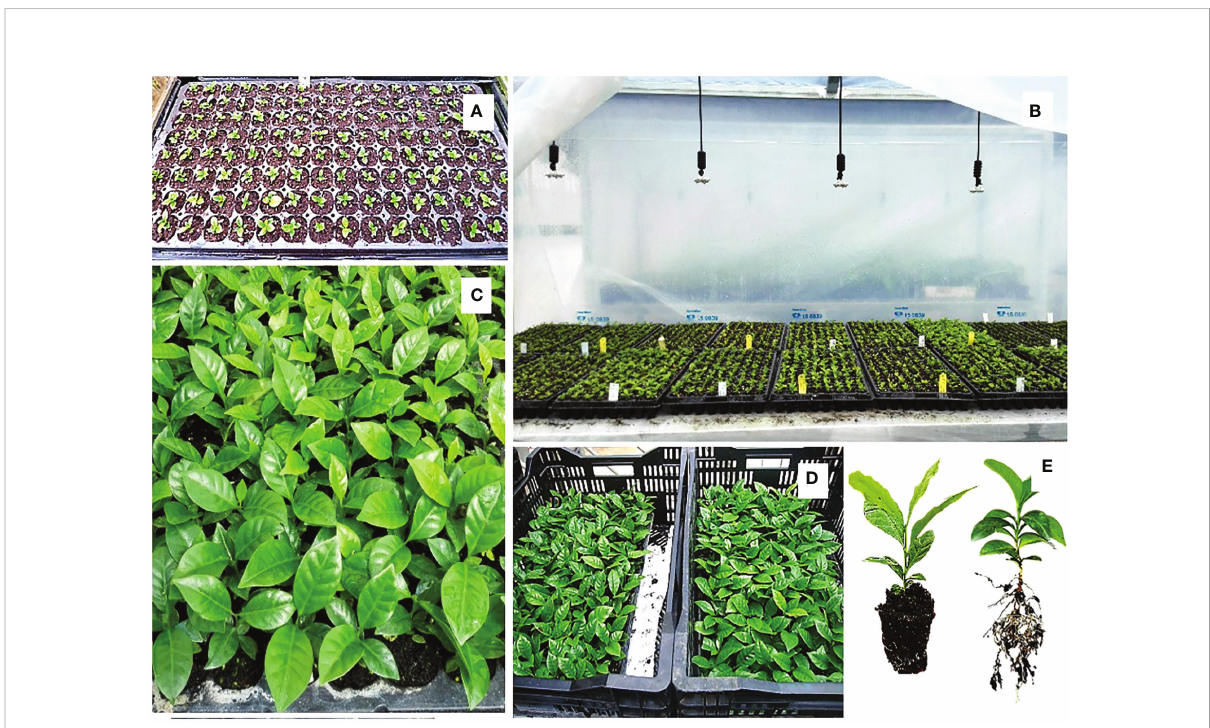
FIGURE 6 Acclimatization of coffee plants produced by somatic embryogenesis. (A) Plants with at least one pair of leaves planted in a tray; (B) plastic tunnels for acclimatization; (C) plants acclimated after 4 months in the greenhouse; (D) mother plants ready for transfer to nurseries for horticultural propagation; (E) morphology of an acclimatized mother plant; observe the good root